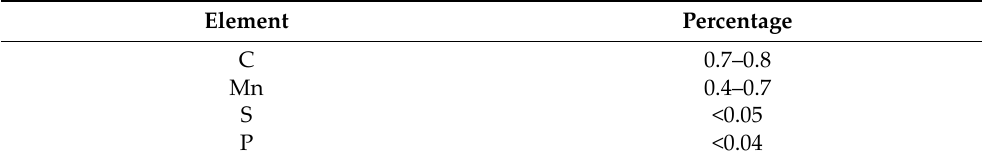
Table 1. Steel 1075 chemical